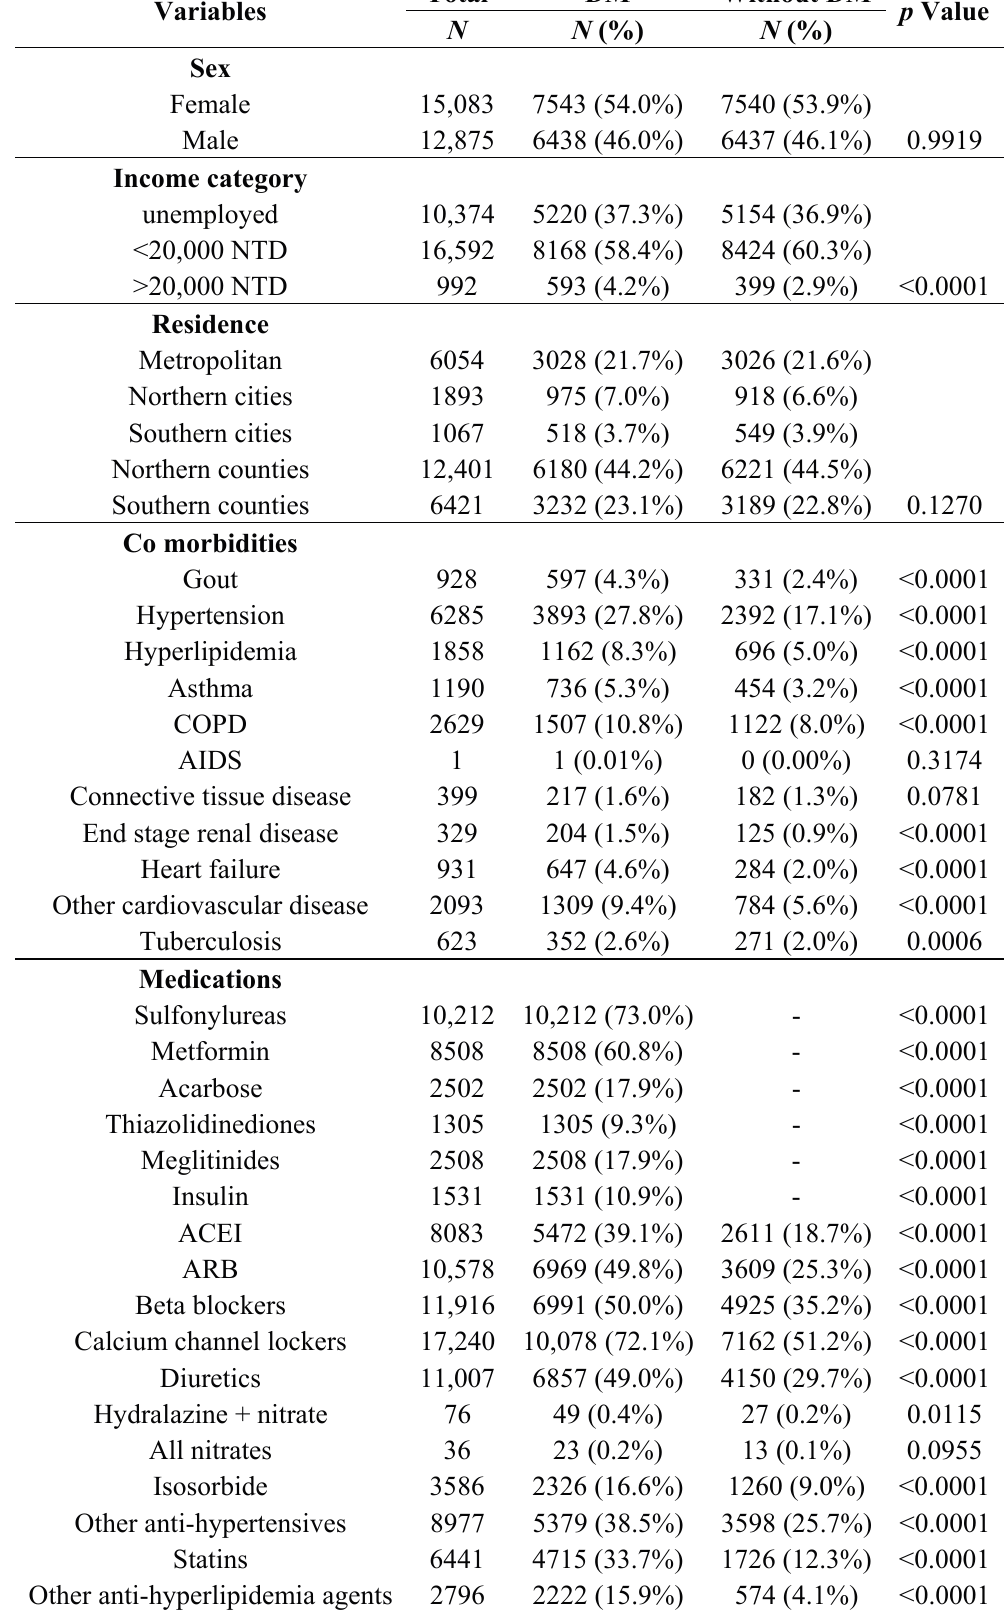
Table 1. Demographic characteristics between those with and without diabetes aged >65